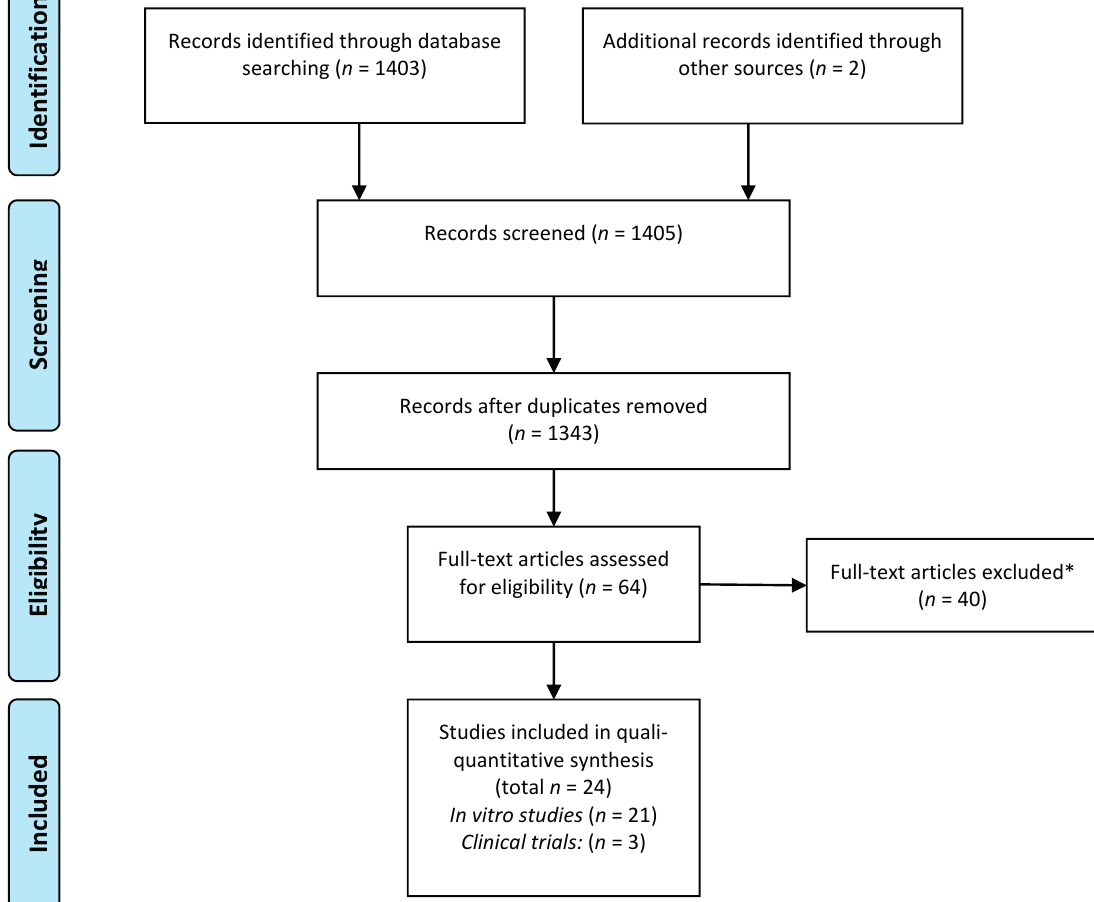
Figure 1. Flow diagram of the search strategy comprising the identification of